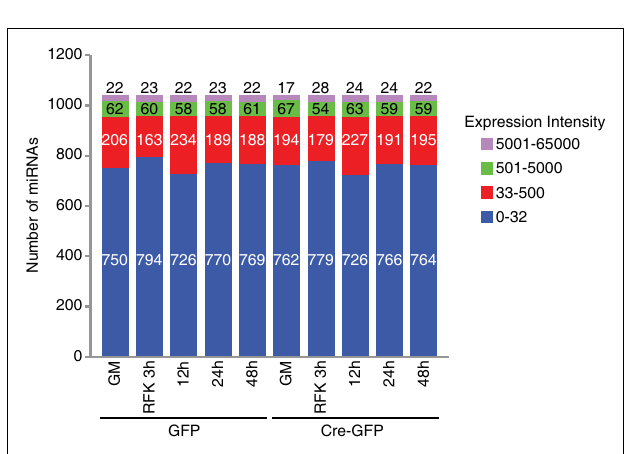
FIGUREA2 | Distribution of the number of miRNAs examined in the array analysis. In NSCs cultured under proliferation and differentiation conditions, only a quarter of the 1040 miRNAs examined are expressed at a significant level (with an intensity above 32). Out of these significantly expressed groups, about 60 miRNAs were expressed at levels between 500 and 5000 and about 20 miRNAs were above 5000.